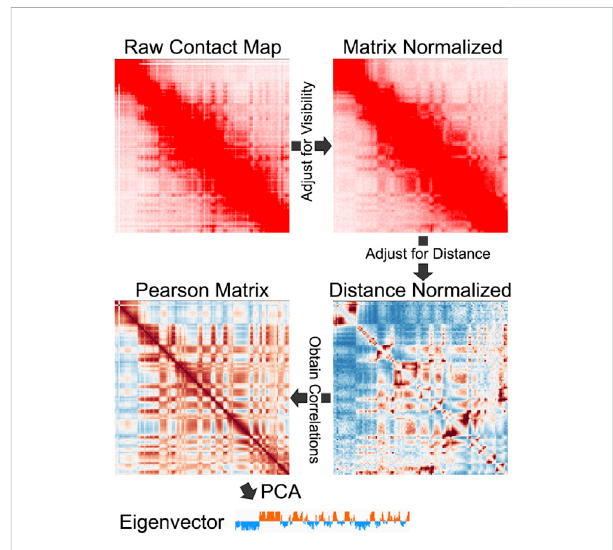
FIGURE 2 An example of the steps involved in A/B compartment identi fi cation, including matrix balancing, distance normalization, Pearson correlation, and PCA. Contact Map from Rowley et al.,